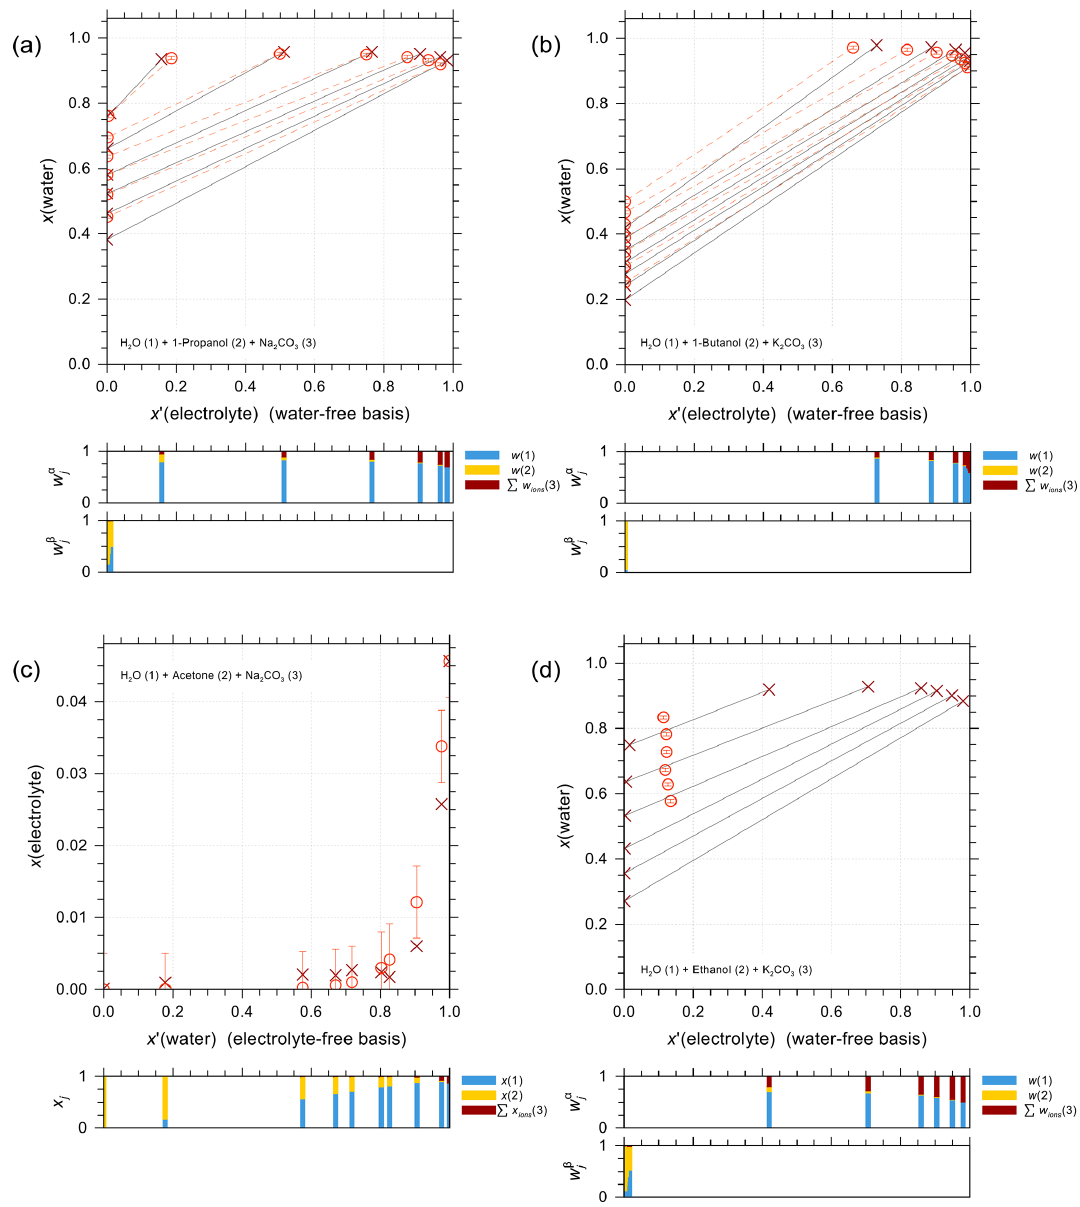
Figure 14. Experimental ( × ) and AIOMFAC-predicted ( ◦ ) equilibrium phase compositions of water + organic compound + carbonate salt systems with model sensitivity shown as error bars. (a) LLE of water (1) + 1-propanol (2) + Na 2 CO 3 (3) at 313K; experiments by Gerlach and Smirnova (2016). (b) LLE of water (1) + 1-butanol (2) + K 2 CO 3 (3) at 298K; experiments by Fu et al. (2020). (c) SLE of Na 2 CO 3 in a water (1) + acetone (2) + Na 2 CO 3 (3) system at 295K; experiments by Ellingboe and Runnels (1966). (d) LLE of water (1) + ethanol (2) + K 2 CO 3 (3) at 298K; experiments by Salabat and Hashemi (2007). The AIOMFAC-LLE model predicts no phase separation for this system (d) . The composition bars show the mass fractions (or mole fractions in c ) of the components with respect to dissociated